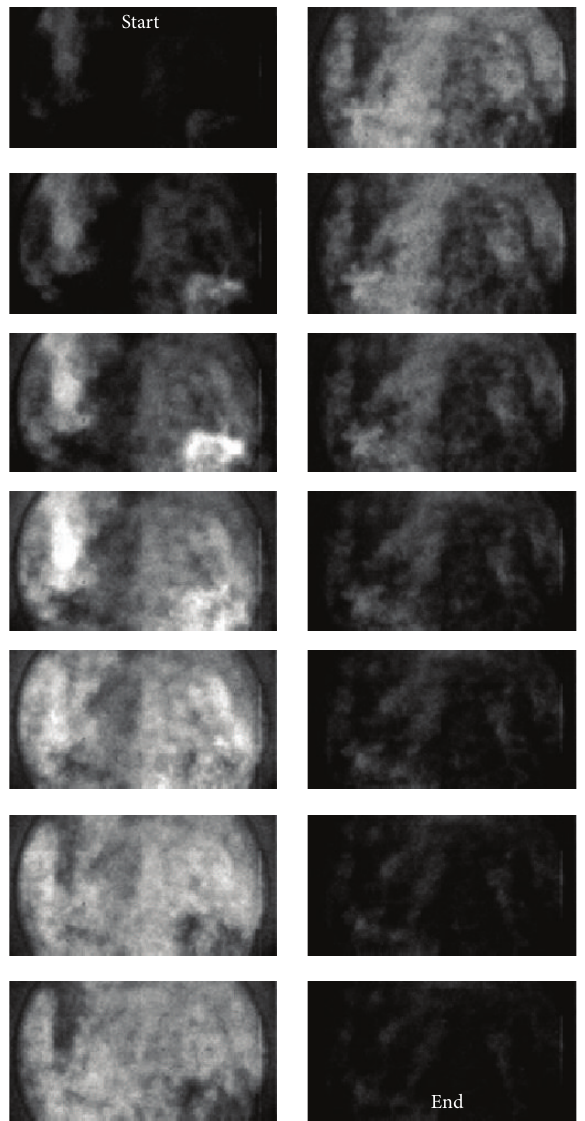
Figure 6: High-speed movie sequence of HCCI (the interval between frames as displayed is 100 𝜇 s (0.71 CAD), and exposure time is 49 𝜇 s per frame)